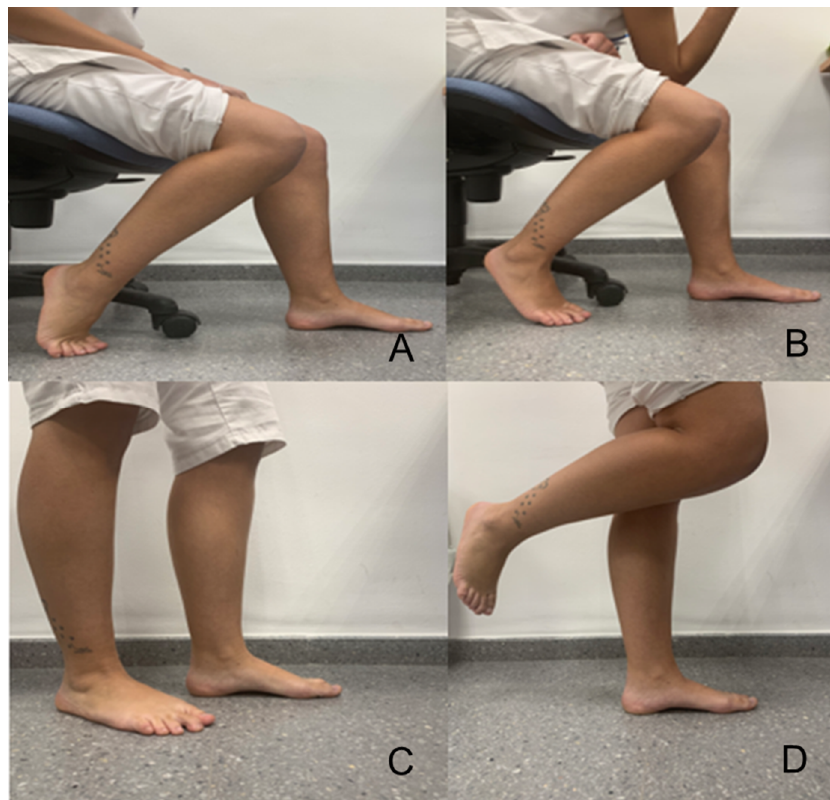
Figure 2. ( A ) Subject sitting—First week of training. ( B ) Subject sitting, support of the left elbow on the knee with the intention of loading on the foot (left) during training with the SFE—Second week of training. ( C ) Subject standing-position, training the left foot with the SFE—Third week of training. ( D ) Subject standing unipodal, with SFE training of the left foot—Fourth week of training. Unipodal standing-position. Seconds during the SFE, alternating with a period of rest at 10 s. A tot al of five series was carried out for each foot [17]. The researcher monitored and verified the daily exercise via telematic control (both groups were followed